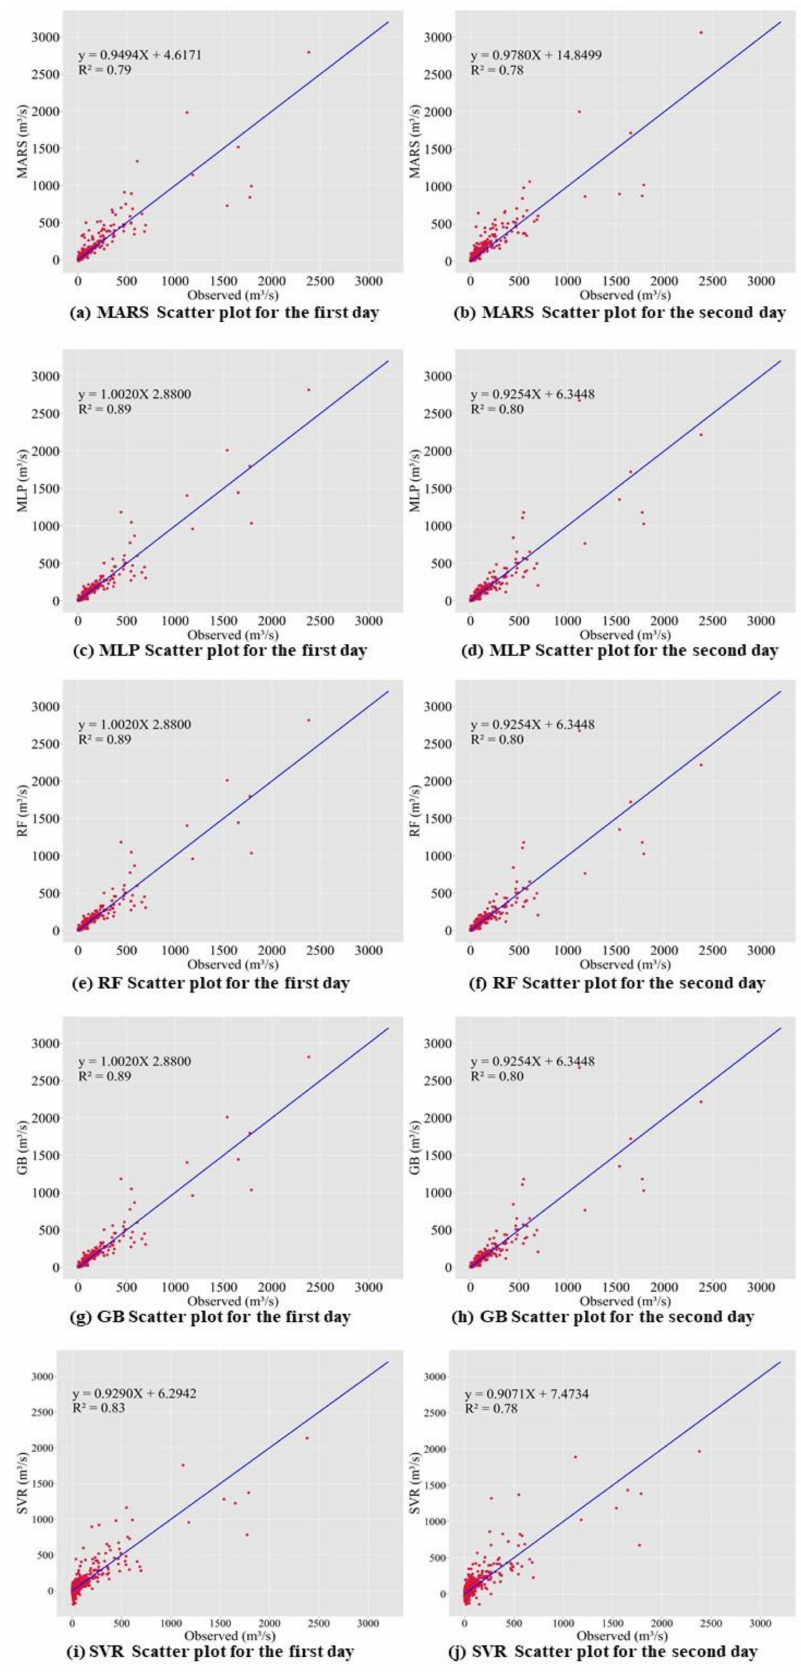
Figure 12. Scatter plot for predicting the inflow rate with baseline